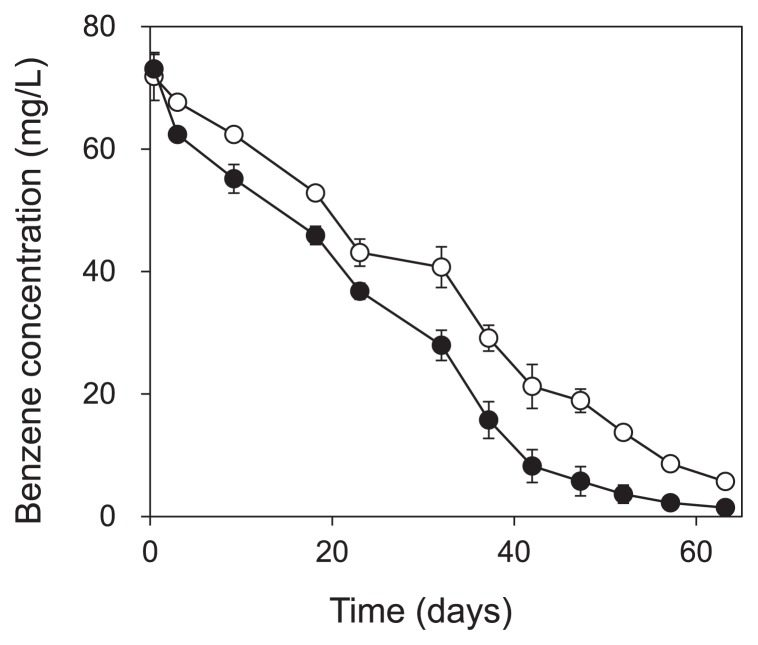
Concentration of benzene during incubation of the ●: labeled treatment, and ○: unlabeled treatment. Error bars show the standard error for triplicate samples.